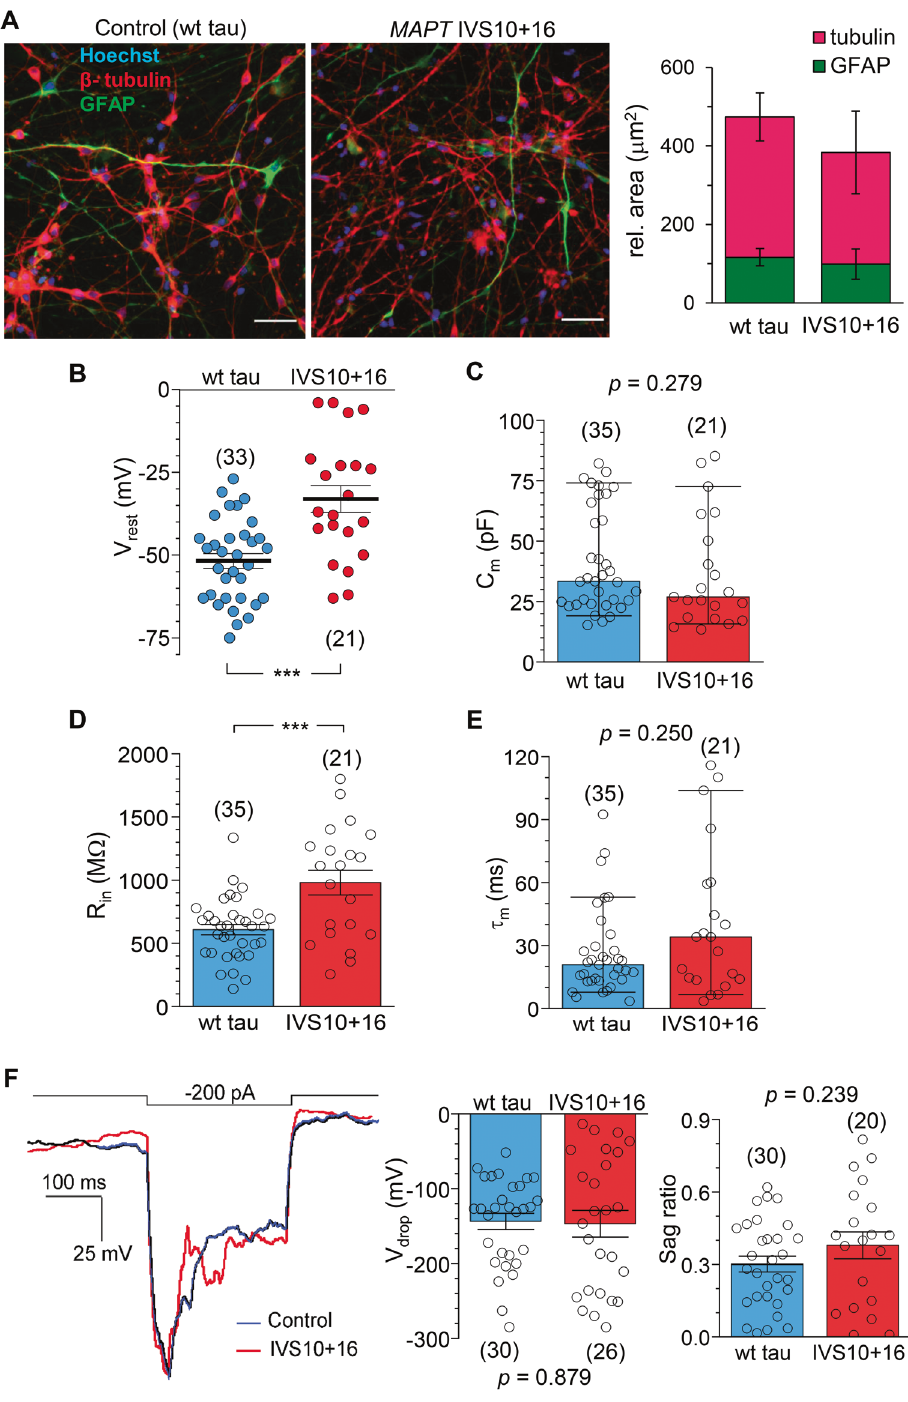
Fig. 2 MAPT IVS10 + 16 neurons display a depolarized resting membrane potential and increased resistance, but unchanged other parameters of interest. A Immuno fl uorescence staining of human iPSC-derived cells for β -tubulin III (red), GFAP (green), and nuclear marker Hoechst 33342 (blue) at 130 DIV in a control cell culture (wt tau, left) and a genetically engineered one (right image). Right, quanti fi cation of the relative area of GFAP versus β -tubulin III shows a similar proportion of astroglia between the isogenic control and MAPT IVS10 + 16 groups (total n = 6 cell cultures per group, p = 0.702; the two-tailed unpaired t -test). B Statistics of the resting membrane potential ( V rest ) of iPSC- derived neurons in control (wt tau) and MAPT IVS10 + 16 groups during late neurogenesis (~190 – 220 DIV). *** P < 0.001 (two-tailed unpaired t - test). C Statistics of the capacitance ( C m ) of iPSC-derived neurons in control (wt tau) and MAPT IVS10 + 16 groups. Boxes show median values. Nonparametric Mann – Whitney test indicated. D Same as in ( B ), but for the input resistance ( R in ). The two-tailed unpaired t -test indicated. E Same as in ( C ), but for the membrane constant ( τ m ). Boxes show median values. Nonparametric Mann – Whitney test indicated. F Left, an overlay of the membrane potential changes in response to a hyperpolarizing current (on the top) in a control (wt tau) neuron (black line) and a MAPT IVS10 + 16 groups. The MAPT IVS10 + 16 neuron (red line). Right plots, statistics of the V drop and the sag ratio of (right) in the wt tau and two-tailed unpaired t -test indicated. All data are mean with s.e.m, unless indicated. The number of tested cells indicated.